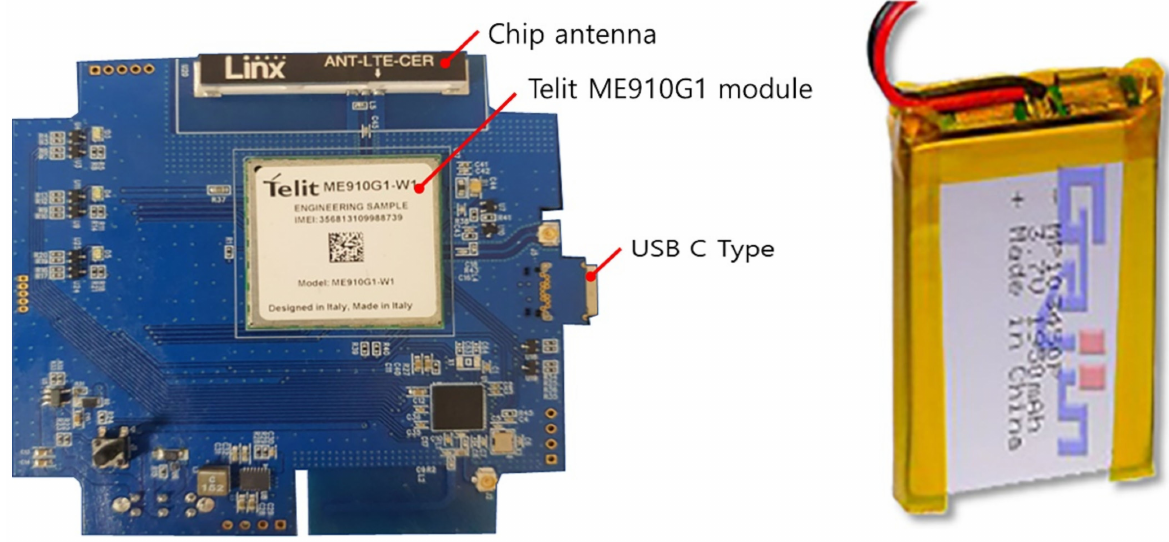
Figure 13. Gateway PCB and lithium